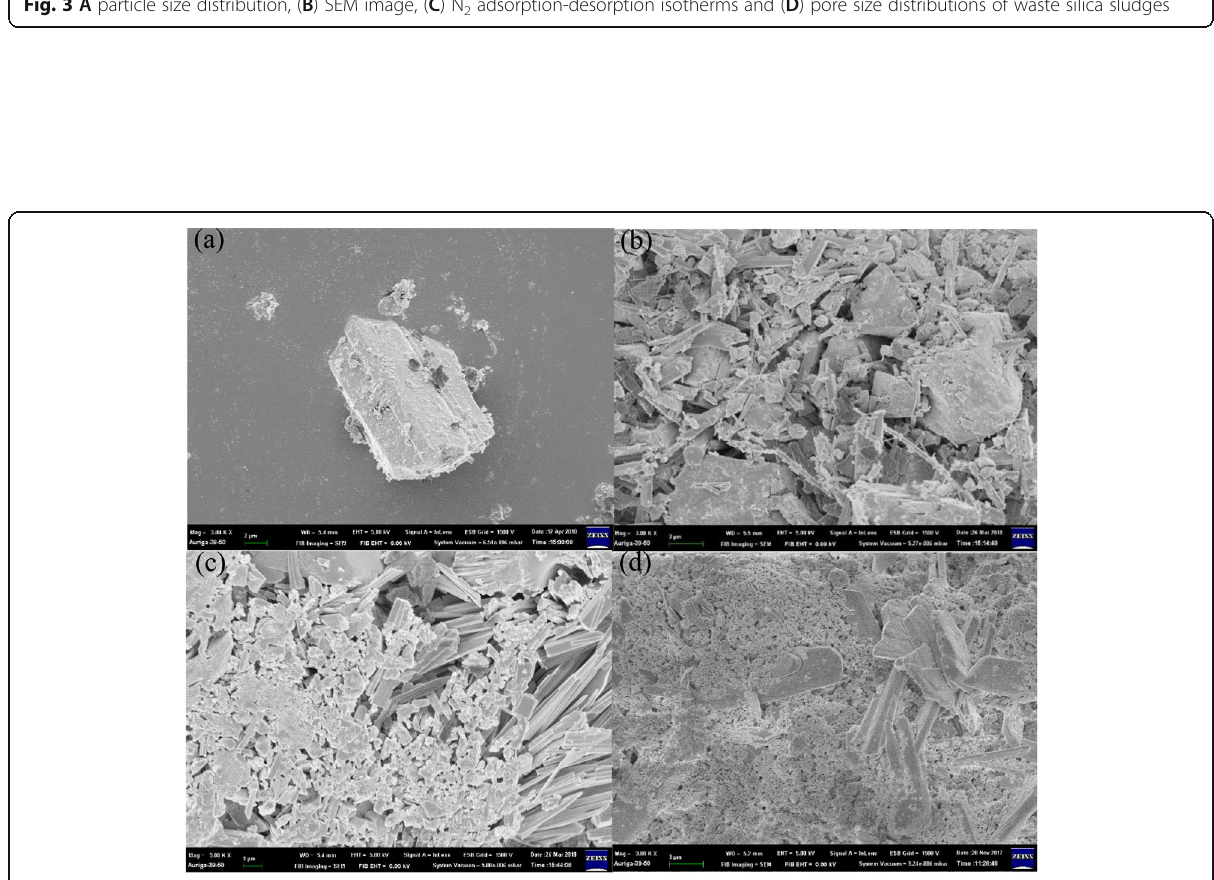
Fig. 4 SEM images of ( A ) bassanite, ( B ) gypsum, and ( C ) IHC-0 and (d)